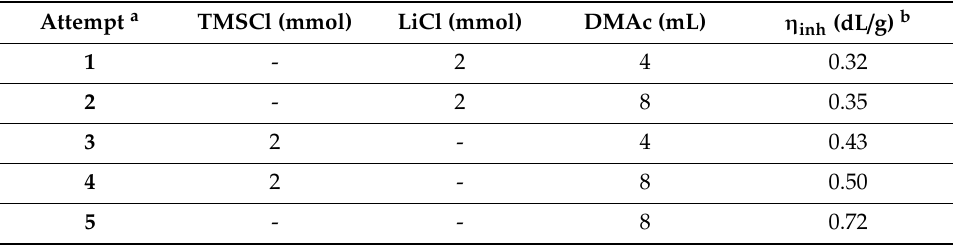
Table 1. Reaction conditions for the synthesis of PI-F using LiCl and TMSCl.